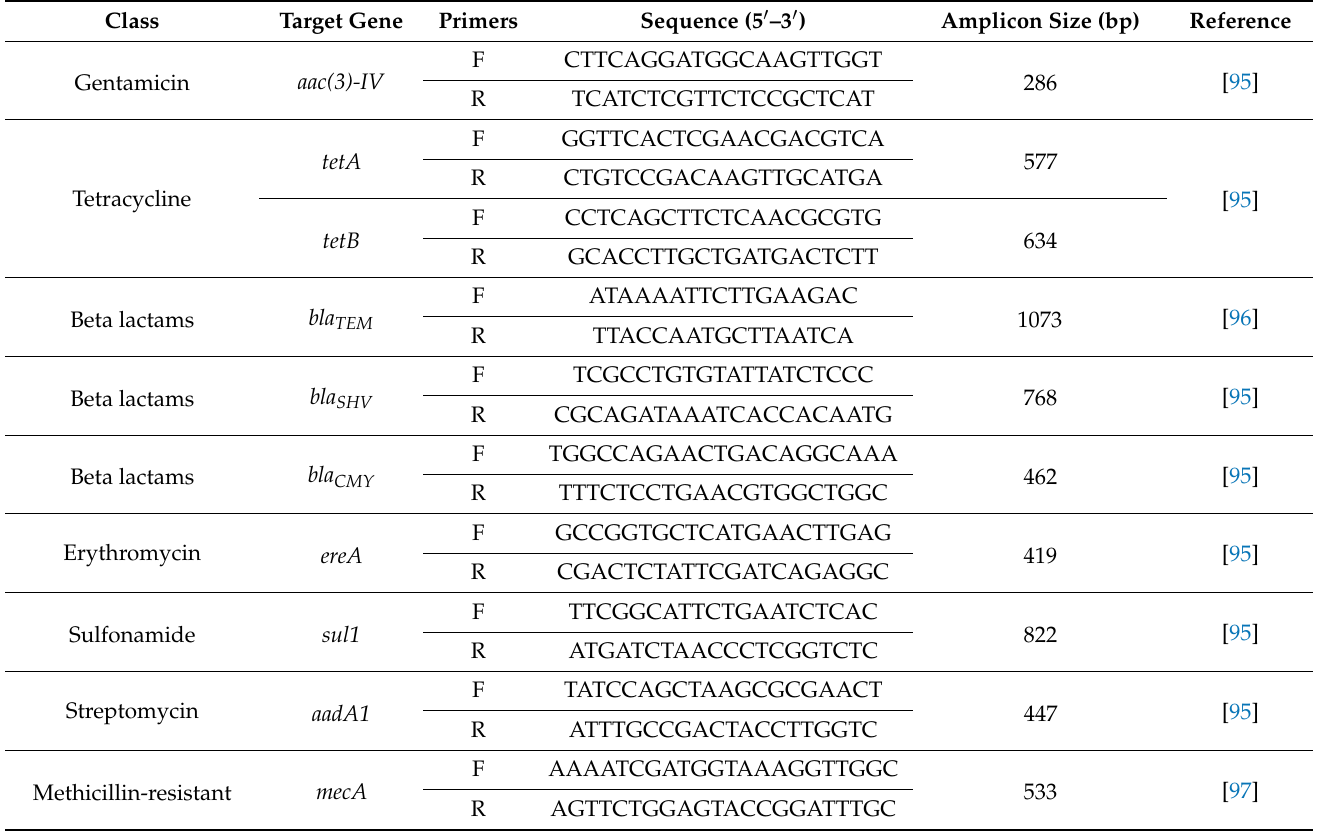
Table 4. List of primers used to detect resistant